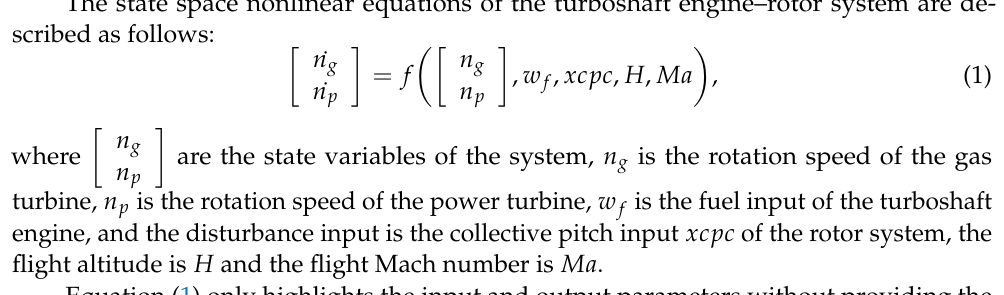
Figure 1. The structure diagram of the turboshaft engine–rotor